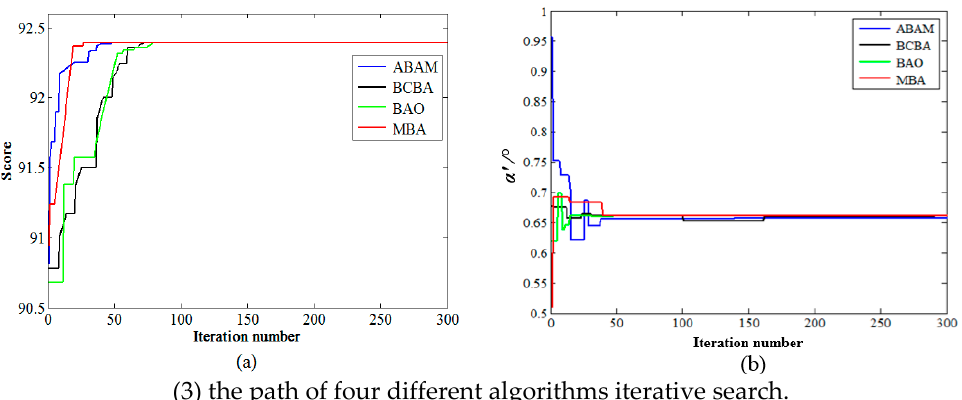
(3) the path of four different algorithms iterative search. Figure 5 . Comparison of optimization results of four different optimization algorithms.